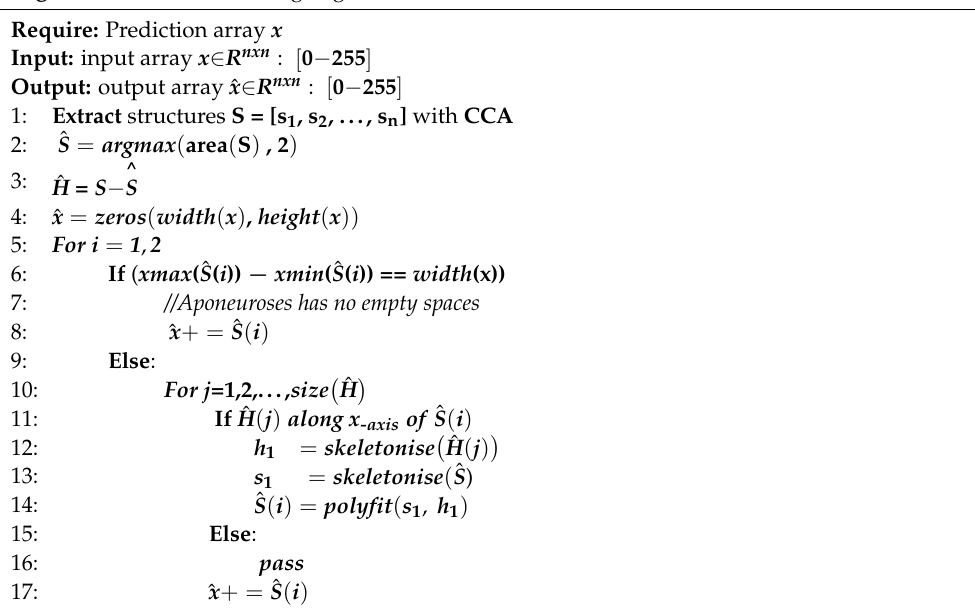
Algorithm 1. Post-Processing Algorithm